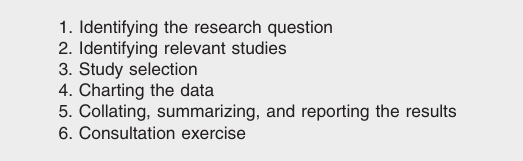
Methodologic framework for scoping reviews as described by Arksey and O’Malley,